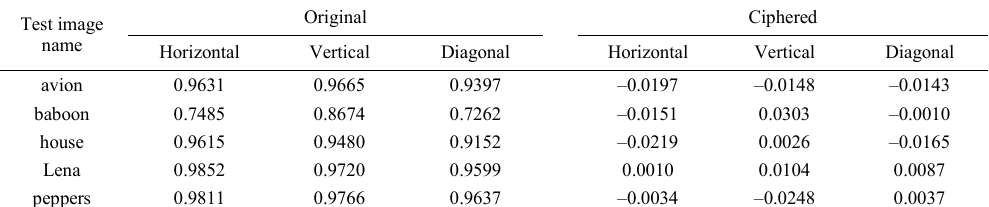
Table 4. Correlation coefficients for adjacent pixels in five test images and their output cipher